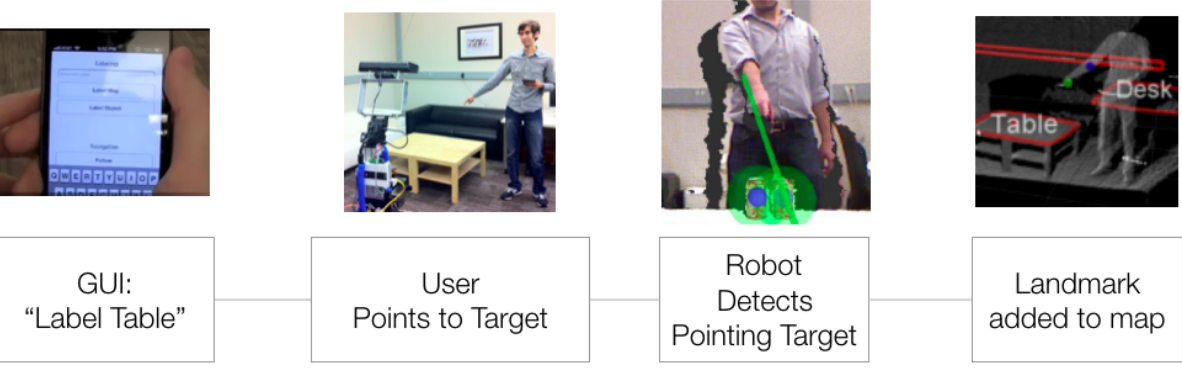
Figure 3: Steps for interactively labeling a landmark in the semantic map. First, the user activates person following using the app. The user stops nearby the target landmark, and enters the requested label using the app. Then the user performs a pointing gesture towards the target and waits for acknowledgement. The robot assesses the likelihood of nearby objects being the intended target, and asks for confir- mation if ambiguity is detected. Finally, a string label is attached to the corresponding landmark in the semantic map.